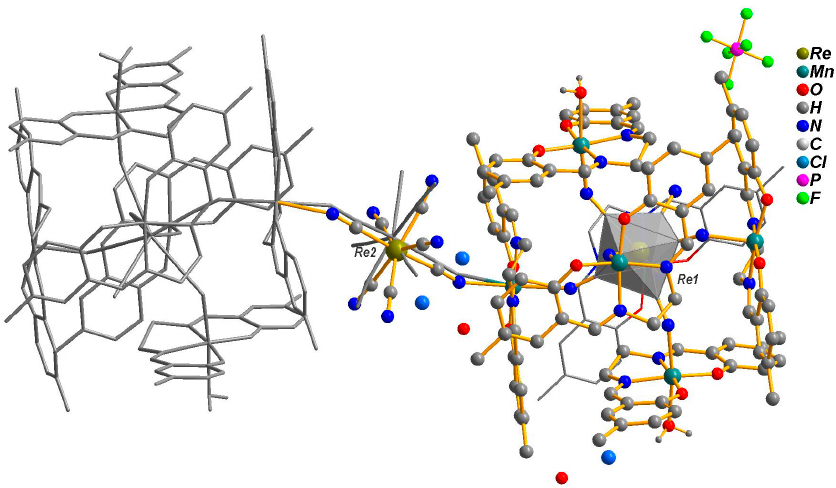
Figure 4. The asymmetric unit (ball-and-stick) of 4 duplicated over the inversion center. The disordered over two positions with occupancy 0.5 central anion [Re(CN) 7 ] 3 − connects the two heptanuclear clusters {(Mn 5Me Salen) 6 (H 2 O) 2 Re(CN) 7 }. Hydrogen atoms are omitted for clarity.